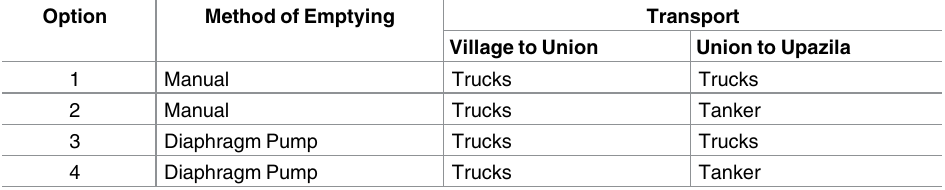
Table 1. Options for modelled